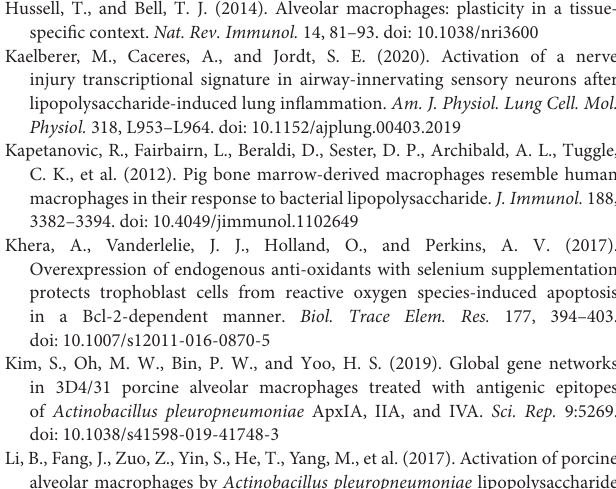
Supplementary Figure 1 | Saturation curve of sequencing of each sample. Each color line represented the saturation curve of gene expression at different expression levels in the sample. Supplementary Figure 2 | Classification of new transcripts. New transcripts were classified according to the overlapping relationship between spliced transcripts and known transcripts. The percentage of new transcripts were shown. Supplementary Figure 3 | Annotation analysis of identified novel genes. The novel genes were annotated using based on GO (A) , KEGG (B) , and COG (C) databases. Supplementary Figure 4 | DEGs in PAMs in response to Se treatment or LPS infection. Volcano plots displaying DEGs in the CON_LPS (A) , CON-SeL (B) , and LPS_SeL (C) groups. The longitudinal dashed lines indicated an expression level of |FC| ≥ 1.5. The horizontal dashed lines indicated an expression level with a p -value < 0.05. Blue dots (up) represented significantly up-regulated genes; gray dots (down) represented significantly down-regulated genes; red dots (no significance) represented insignificantly DEGs. Supplementary Figure 5 | KEGGChord plot of top 20 ranked KEGG terms. Chords indicated a detailed relationship between the expression levels of DEGs (left semicircle perimeter) in the CON_LPS (A) , LPS_SeL (B) , and CON-SeL (C) groups and their enriched KEGG pathways (right semicircle perimeter). The genes were linked to their annotated KEGG terms via colored ribbons. Genes were ordered according to log 2 FC. Supplementary Figure 6 | GOChord plot of top 20 ranked GO terms. Chords indicated a detailed relationship between the expression levels of DEGs (left semicircle perimeter) in the CON_LPS (A) , LPS_SeL (B) , and CON-SeL (C) groups and their enriched KEGG pathways (right semicircle perimeter). The genes are linked to their annotated terms via colored